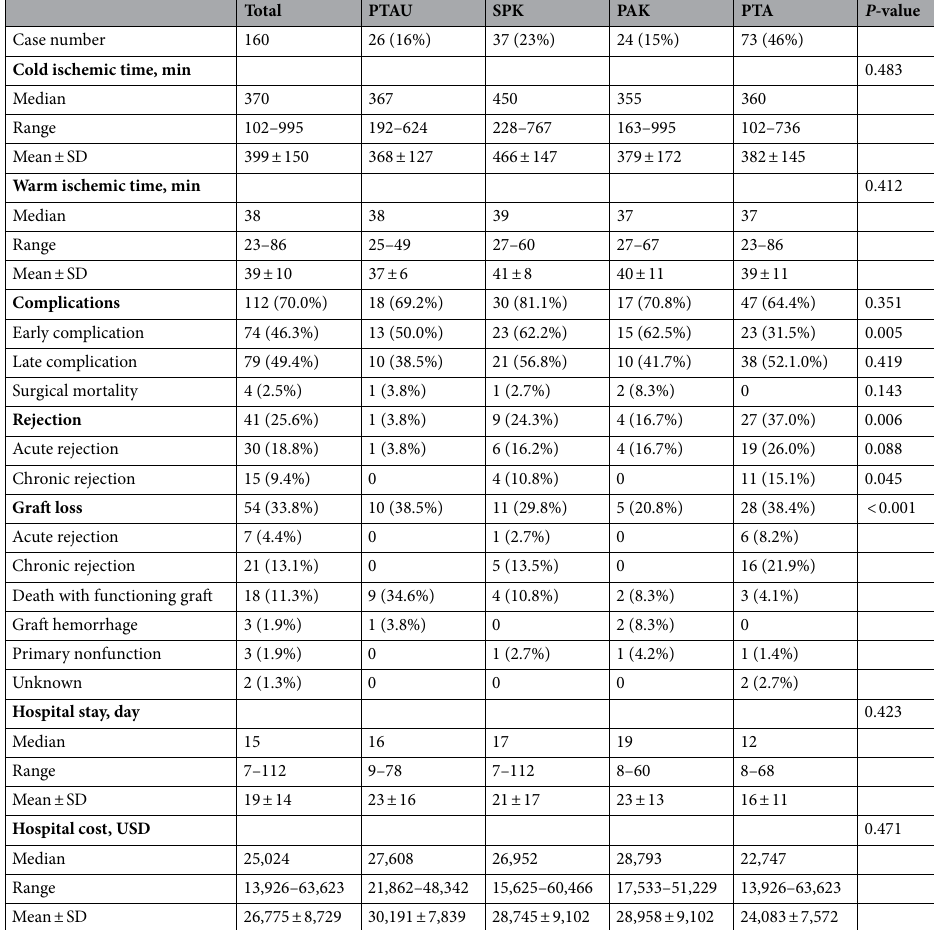
Table 5. Surgical and immunological outcomes for diabetic patients after pancreas transplant. PTAU pancreas transplant alone in uremic patients, SPK simultaneous pancreas and kidney transplant, PTA pancreas transplant alone, PAK pancreas after kidney transplant, USD United States